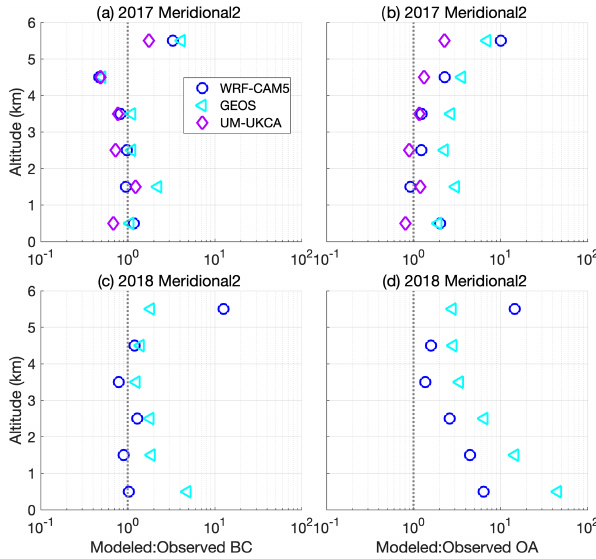
Figure 13. As in Fig. 12 but for the 2017 and 2018 meridional 2 comparison transect. The ratios for individual grid boxes, along with these means, are given in the Supplement (Fig. S9 for WRF- CAM5, Fig. S11 for GEOS, and Fig. S13 for UM-UKCA).